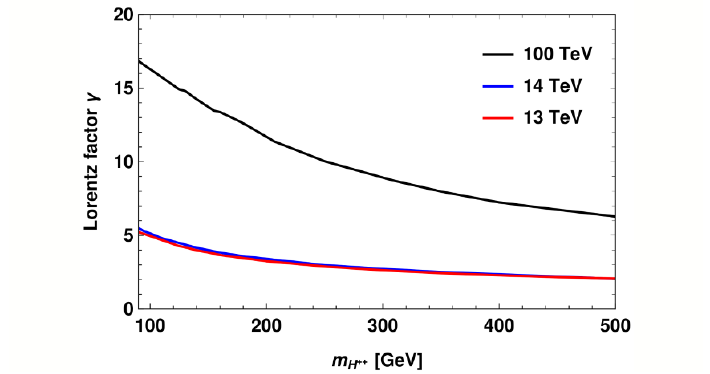
for p s = 13 TeV, 14 TeV and 100 TeV. H (cid:6)(cid:6)